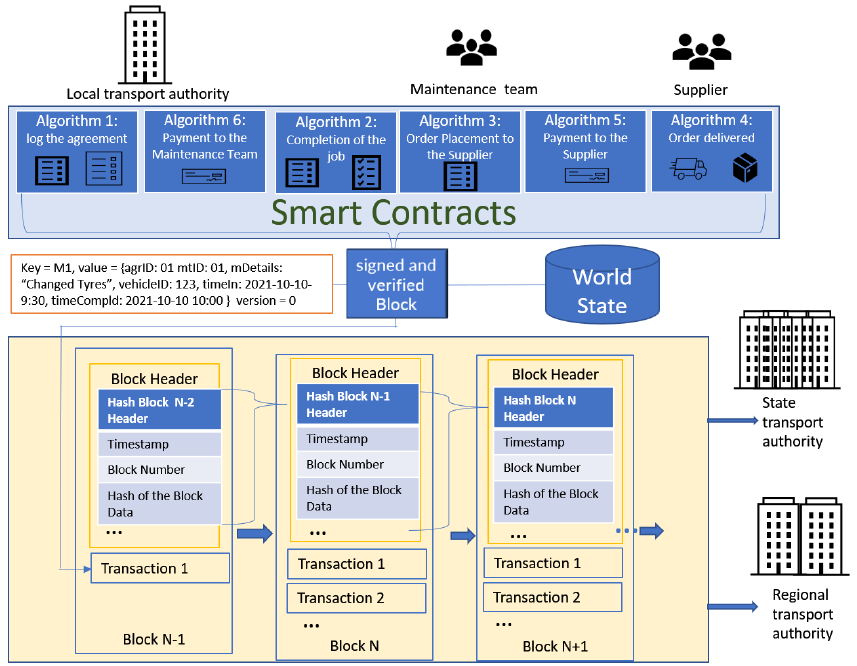
Figure 2. Blockchain and Smart